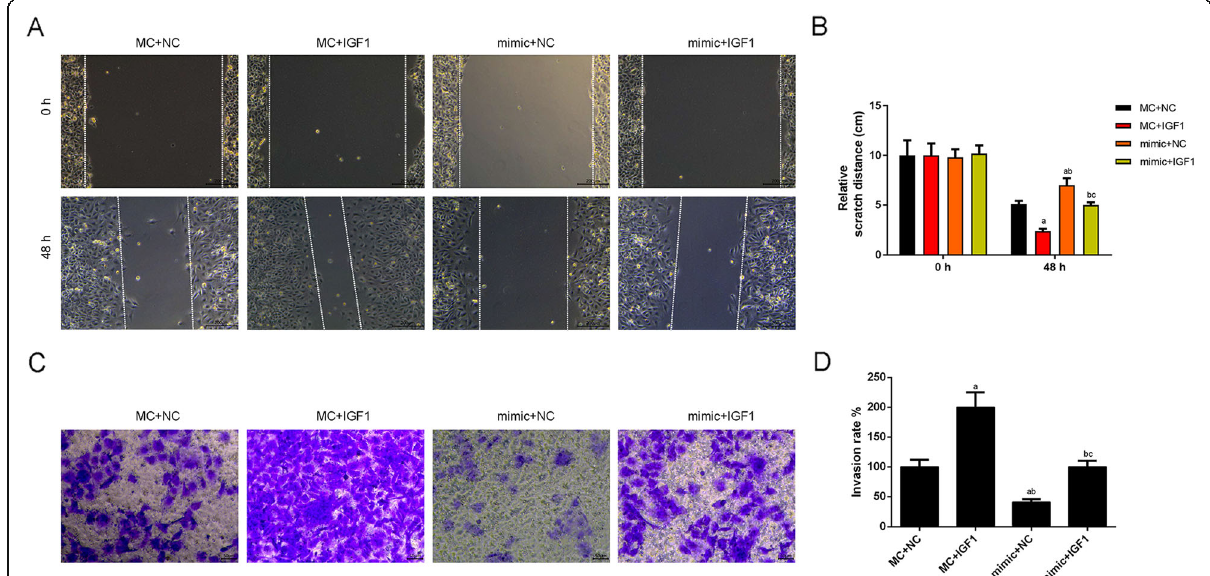
Fig. 9 The up-regulation of miR-126 suppressed migration and invasion by regulating IGF1. ( a ) CHON-001 cells migration was inhibited by miR-126 mimic, which was reversed by IGF1 using wound healing assay. ( b ) The distance of scratch was quantified. ( c ) CHON-001 cells invasion was inhibited by miR-126 mimic, which reversed by IGF1 using transwell assay. ( d ) The numbers of invasion cells was quantified. a P < 0.05 vs. MC + NC, b P < 0.05 vs. MC + IGF1, c P < 0.05 vs.